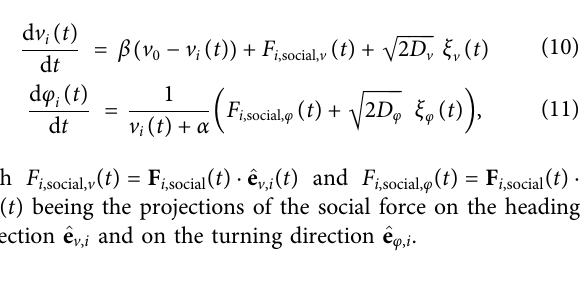
Frontiers in Physics |